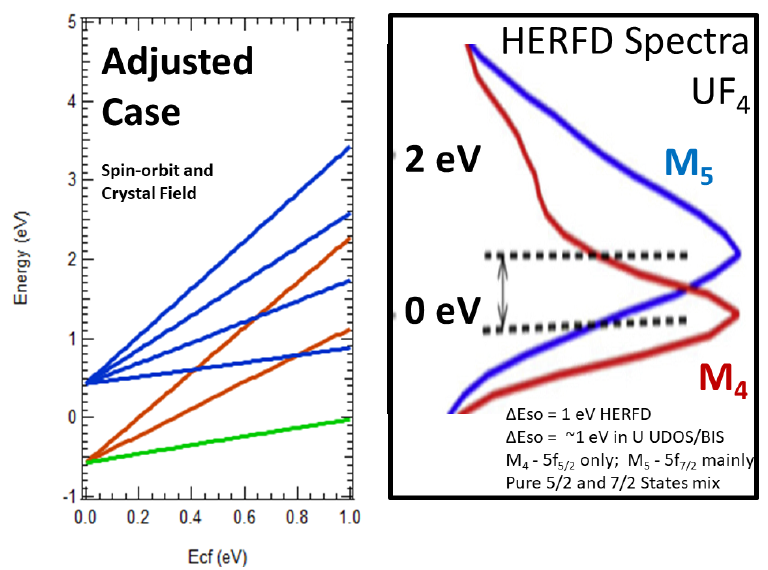
Figure 11. Comparison of the first order perturbation model with Δ E so = 1 eV vs. the M 4,5 HERFD XAS spectra. The spin orbit splitting in the HERFD is not an adjustable parameter. The lowest pair of states (green) is filled and does not contribute to HERFD/XAS.